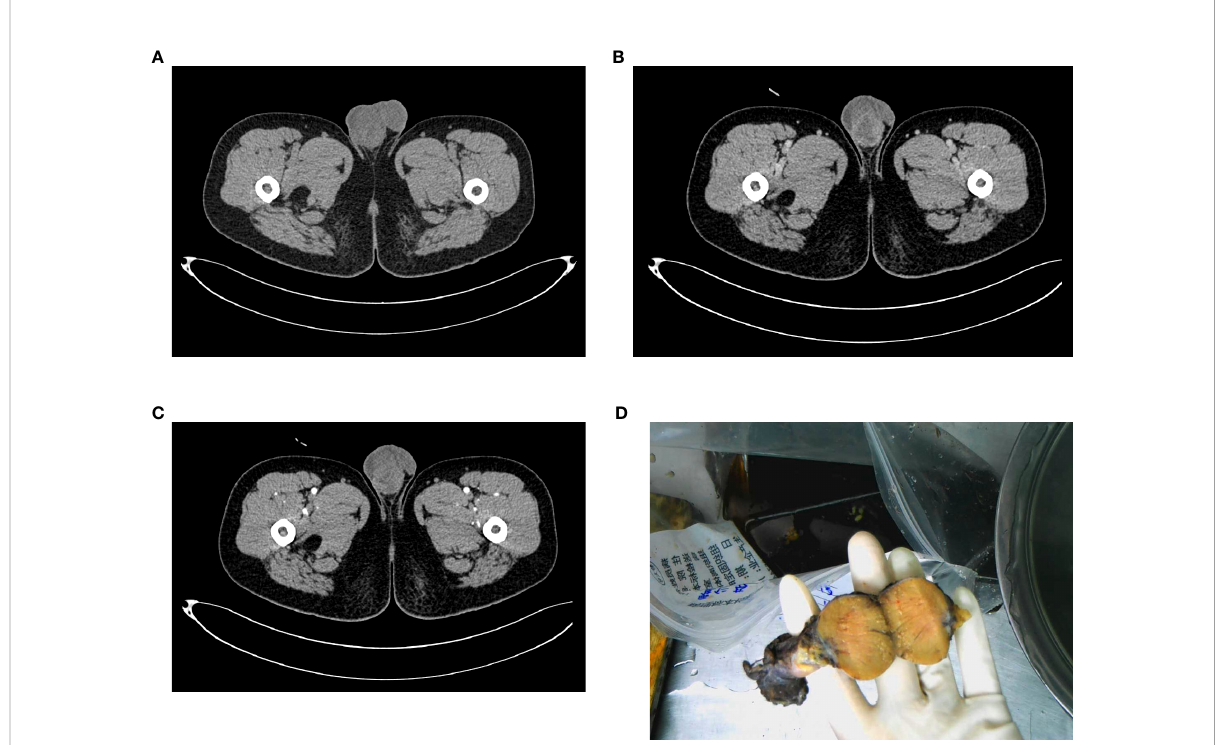
FIGURE 1 Imaging presentation and gross specimen of a patient with primary eRMS. (A) CT plain scan showed the enlarged and inhomogeneous density of the right testicle; (B) (arterial phase) and (C) (venous phase): CT enhanced scan showed inhomogeneous enhancement of the occupying lesion; (D) General